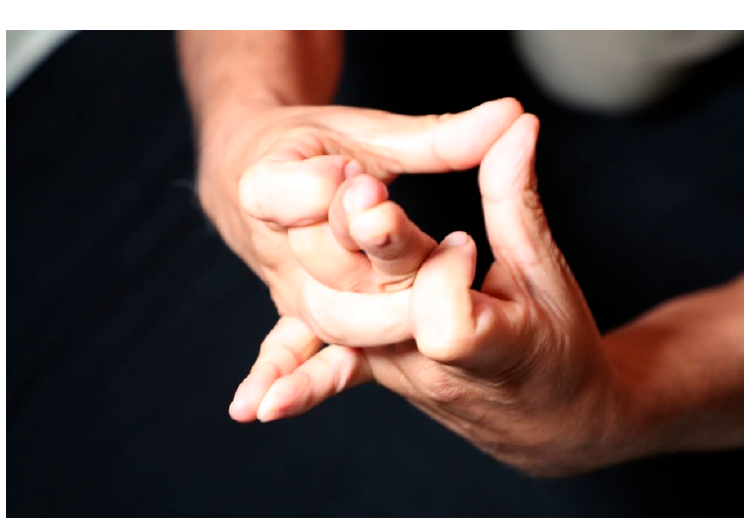
Figure 9. B ī ja-Mudr ā . Figure 9. B¯ıja-Mudr¯a.